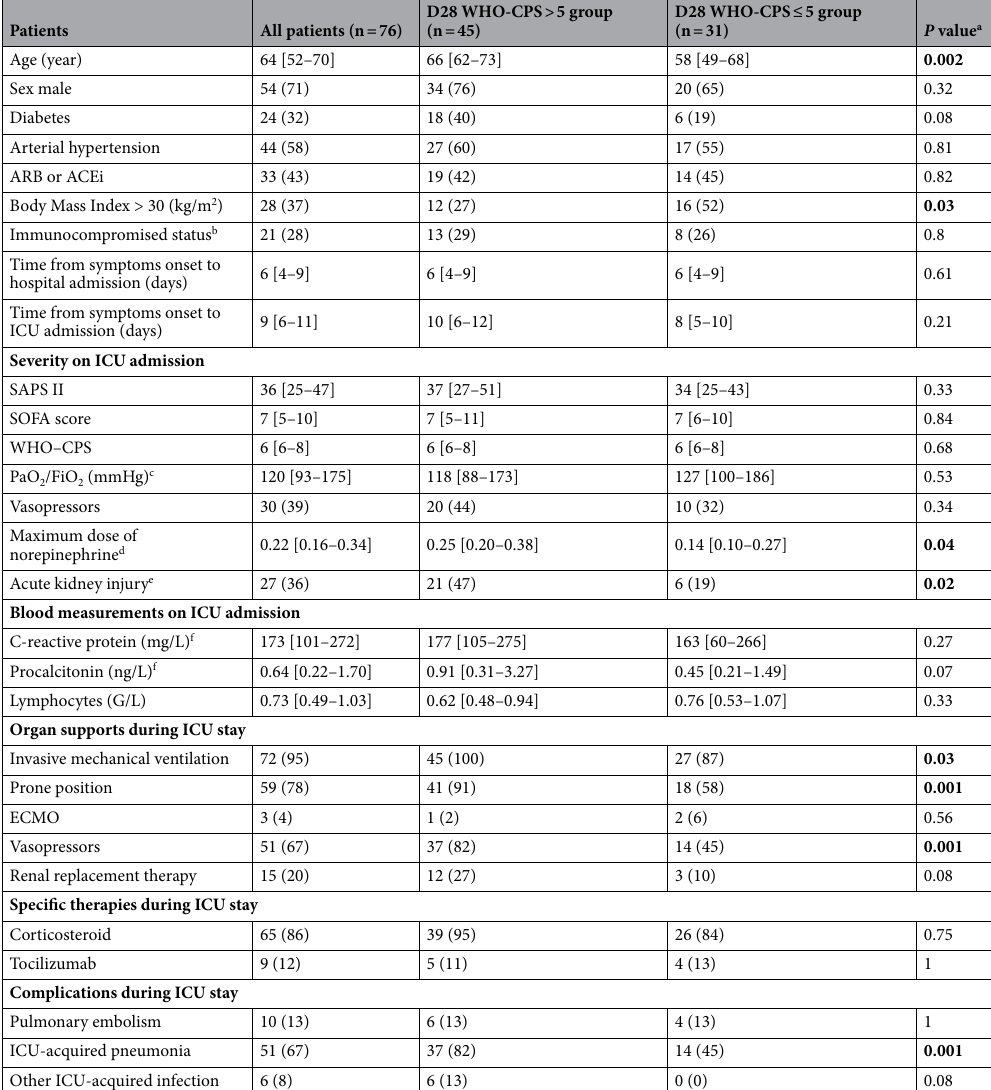
Table 1. Baseline characteristics, management and outcomes of critically ill COVID-19 patients, according to the 28-day World Health Organization 10-point Clinical Progression Scale (WHO-CPS). Data are presented as median [first through third quartiles] or number (%). Patients were grouped according to their WHO-CPS value at 28-day. A score value higher than 5 (D28-WHO-CPS > 5) defined a poor 28-day outcome, whereas a score value equal or lower than 5 (D28-WHO-CPS ≤ 5) defined a good 28-day outcome. ARB angiotensin receptor blocker, ACEi angiotensin-converting enzyme inhibitor, ECMO extra-corporeal membrane oxygenation, ICU intensive care unit, SAPS II simplified acute physiologic score II, PaO2/FiO2 ratio of the partial pressure of oxygen/inspired fraction of oxygen, SOFA sequential organ failure assessment, WHO-CPS World Health Organization 10-point clinical progression scale. a P values refer to differences between D28- WHO-CPS > 5 and D28-WHO-CPS ≤ 5 groups. Boldface values indicate statistically significant differences between the groups. b Immunocompromised patients were distributed as followed: long-term corticosteroid, n = 8; kidney transplant, n = 7; cancer, n = 3; HIV, n = 2; sickle cell, n = 1. c Patients received either invasive mechanical ventilation (n = 32 in D28-WHO-CPS > 5 group; n = 25 in D28-WHO-CPS ≤ 5 group) or high flow oxygen (n = 13 in D28-WHO-CPS > 5 group; n = 6 in D28-WHO-CPS ≤ 5 group). d Maximum dose of norepinephrine in µg/kg/minute. e Acute kidney injury (AKI) was defined as an absolute increase of serum creatinine of ≥ 0.3 mg/dL or relatively ≥ 1.5 times of baseline creatinine. f CRP and procalcitonin were available in 68 patients (n = 41 in D28-WHO-CPS > 5 group; n = 27 in D28-WHO-CPS ≤ 5 group) and 75 patients (n = 44 in D28-WHO-CPS > 5 group; n = 31 in D28-WHO-CPS ≤ 5 group),